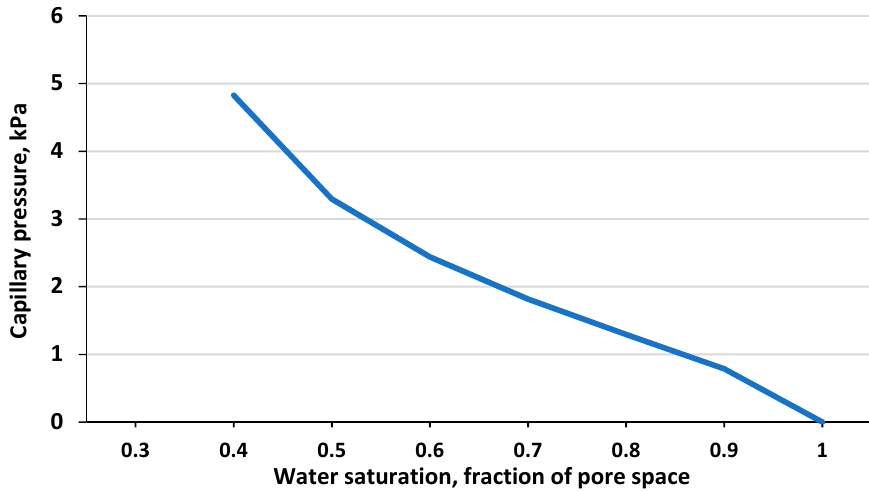
Figure 7. Capillary pressure curve used in numerical modelling.